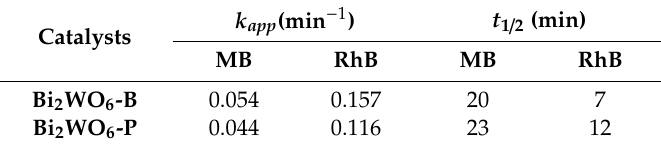
Table 1. Pseudo-first order rate constants and half-life for the degradation of MB and RhB dyes.